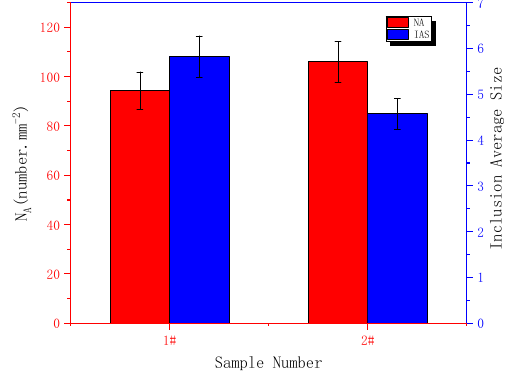
Figure 6. The d ensity and average size of inclusions. Figure 6. The density and average size of